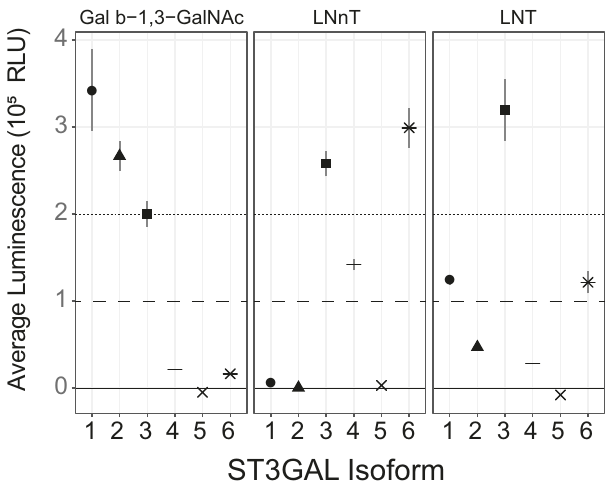
Fig. 6 Results of the CMP-Glo ™ Glycosyltransferase Assay to test GT candidates on relevant HMO acceptors. Average luminescence below 10,000 is considered weak activity, and activity above 200,000 is considered very high activity. Reported luminescence values were background corrected and 95% con fi dence intervals are shown. For complete details see Supplementary Table 4. Shapes correspond to ST3GALT performed DE on HMO substructure abundances and substructure